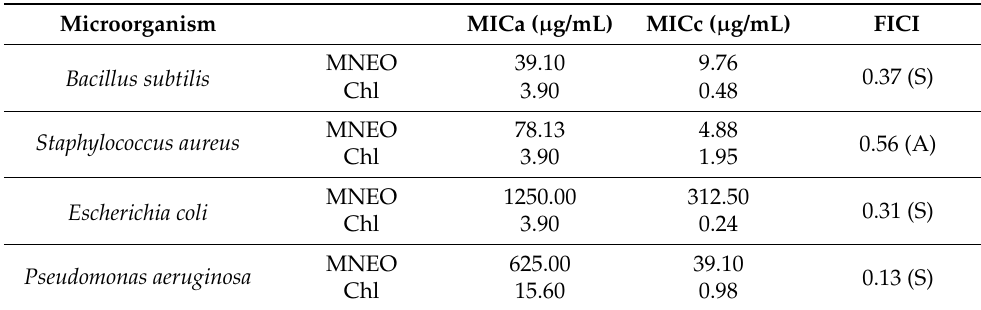
MICa: MIC alone; MICc: MIC combined; Chl: chloramphenicol. S, synergy; A,